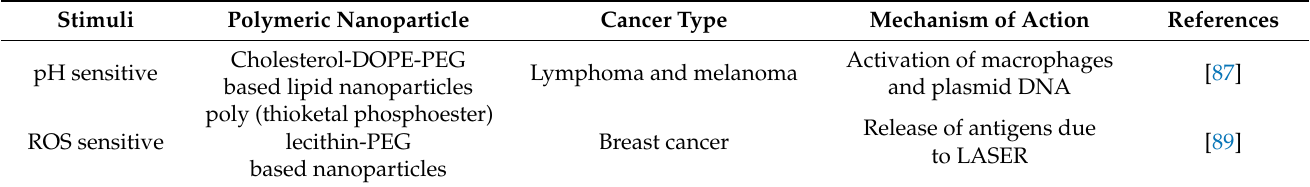
Table 5. Endogenous stimuli-based polymer nanoparticles for delivery of adjuvants.